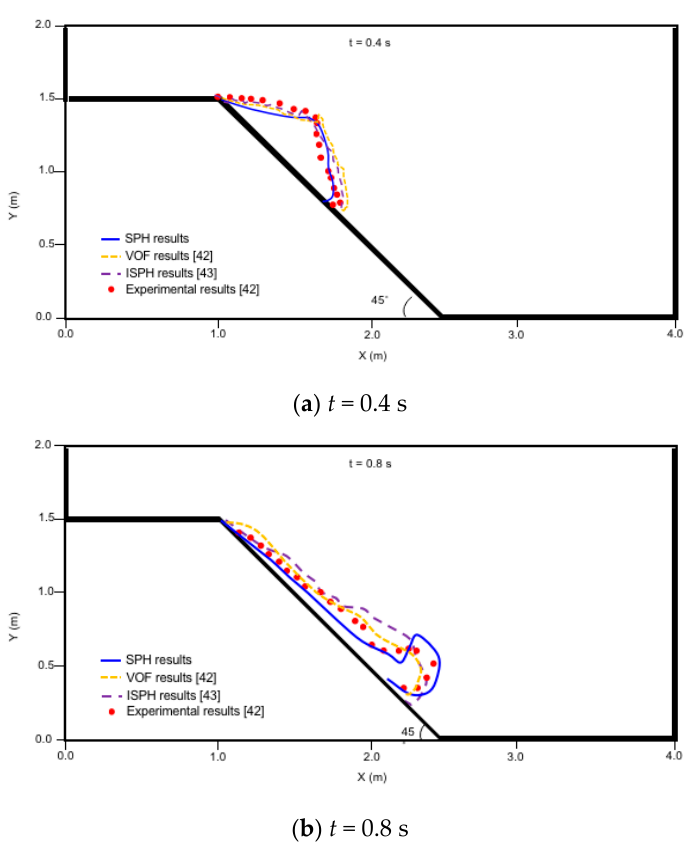
Figure 10. SPH simulated results for the underwater sand flow: ( a ) t = 0.2 s; ( b ) t = 0.4 s; ( c ) t = 0.6 s; ( d ) t = 0.8 s. Table 4. Correlation coefficients between the experimental and numerical results on the water pro- files.